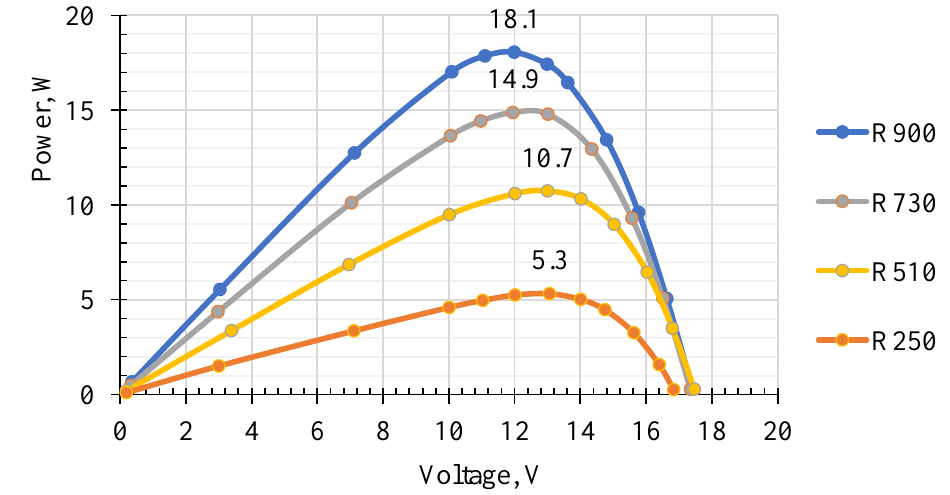
Figure 10. VWC of the photovoltaic module at different solar radiation intensities: (R900) at an average intensity of 900 W/m 2 ; (R730) at 730 W/m 2 ; (R510) at 510 W/m 2 ; (R250) at 250 W/m 2 . As can be seen from the figure, the maximum power of the module was about 18 W at an SI intensity of 900 W/m 2 . Immediately after taking the characteristics, the module was connected directly to the lighting system according to the scheme shown in Figure 2. At the same time, with the use of the monitoring system, its operating parameters were recorded for 30 s. The data of these measurements are shown in Figure 11. The power taken from the PVM was determined by calculation using the current and voltage sensor S1 (see Figure